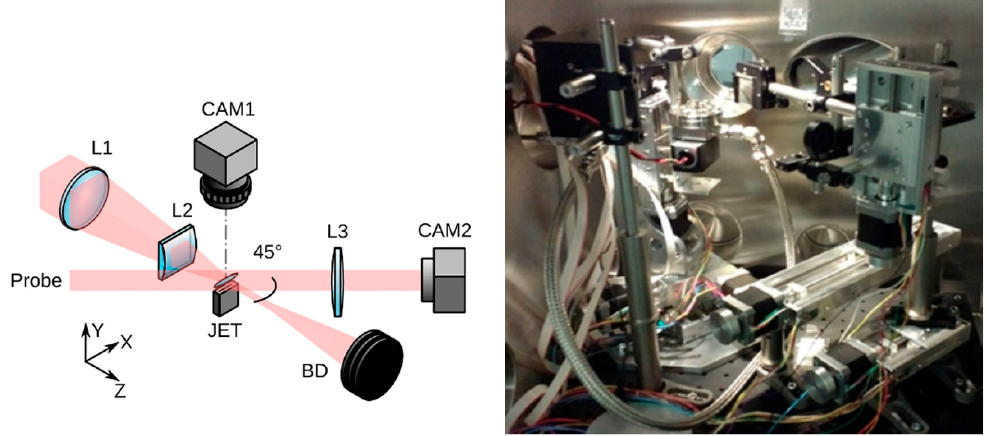
Figure 5. Experimental setup. A laser pulse of 1–5-joule and 10-ns time duration with a 1030-nm wavelength, is sent towards an optical system based on a plano-convex and a cylindrical lens to generate an elongated focus in a gas jet target. A portion of the main laser pulse is used as optical probe. L1 is an f = 200-mm plano-convex lens, L2 is an f = 100-mm cylindrical lens. L3 is an f = 150-mm plano-convex lens used for shadowgraphy on CAM2. CAM1 is used as top-view image of the optical plasma emission. BD is a beam-dump.